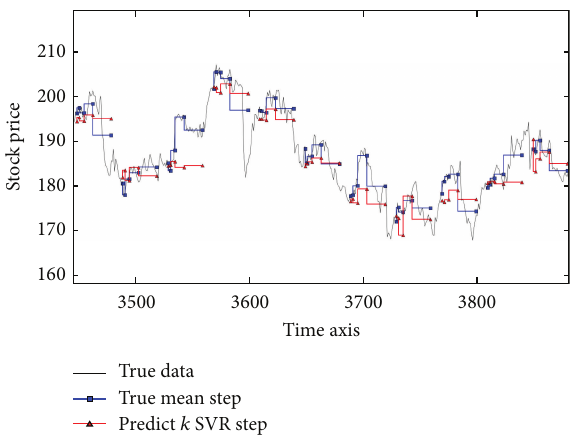
Figure 6: IBM stock price trend